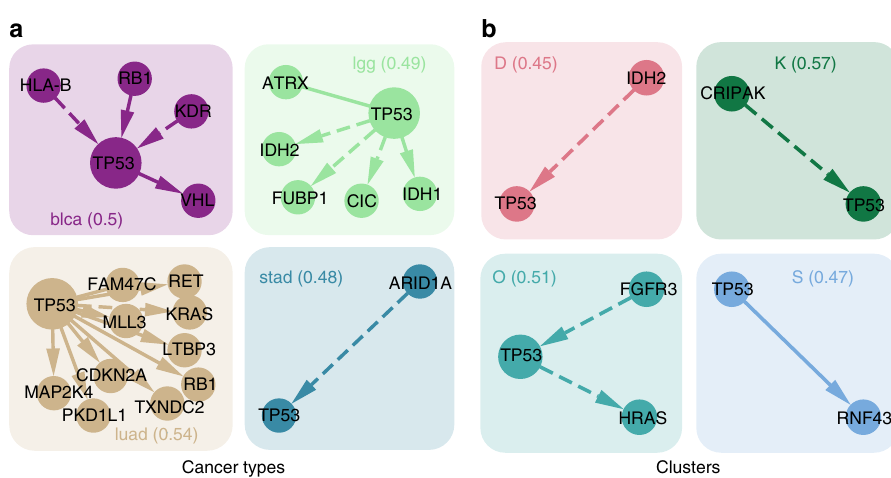
Fig. 6 Focus on TP53 . a Cancer types or b clusters are characterised by interactions of TP53 with different genes. For cancer types or clusters where TP53 shows a similarly high mutation frequency (around 0.5), we display all its interactions (positive correlation is represented by solid arrows, negative correlation by dashed). Groups are annotated by the cancer type or cluster name and the respective mutation frequency of TP53 across samples (in brackets). Several of these interactions have been studied in cancer. For example, an inverse relationship between ARID1A and TP53 was previously observed in gastro-intestinal cancers 52 while TP53 mutations co-occur with RB1 in bladder cancer